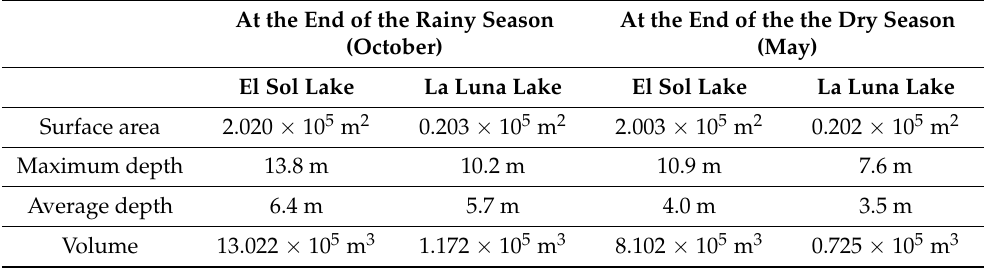
Table 1. Hydrological parameters for Lake El Sol and Lake La Luna. Modified from Filonov et al. [35]. At the End of the Rainy Season